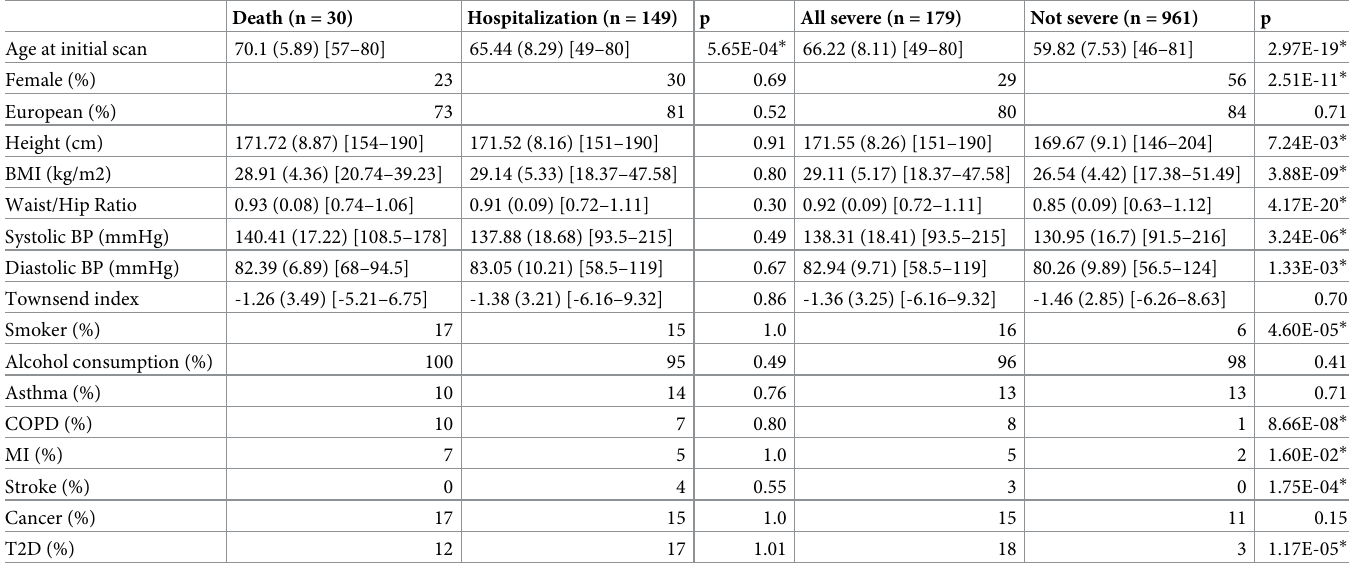
Table 3. Baseline demographics for all SARS-CoV-2 positive cases in the UK Biobank with baseline imaging data, stratified by severity of COVID-19 disease.